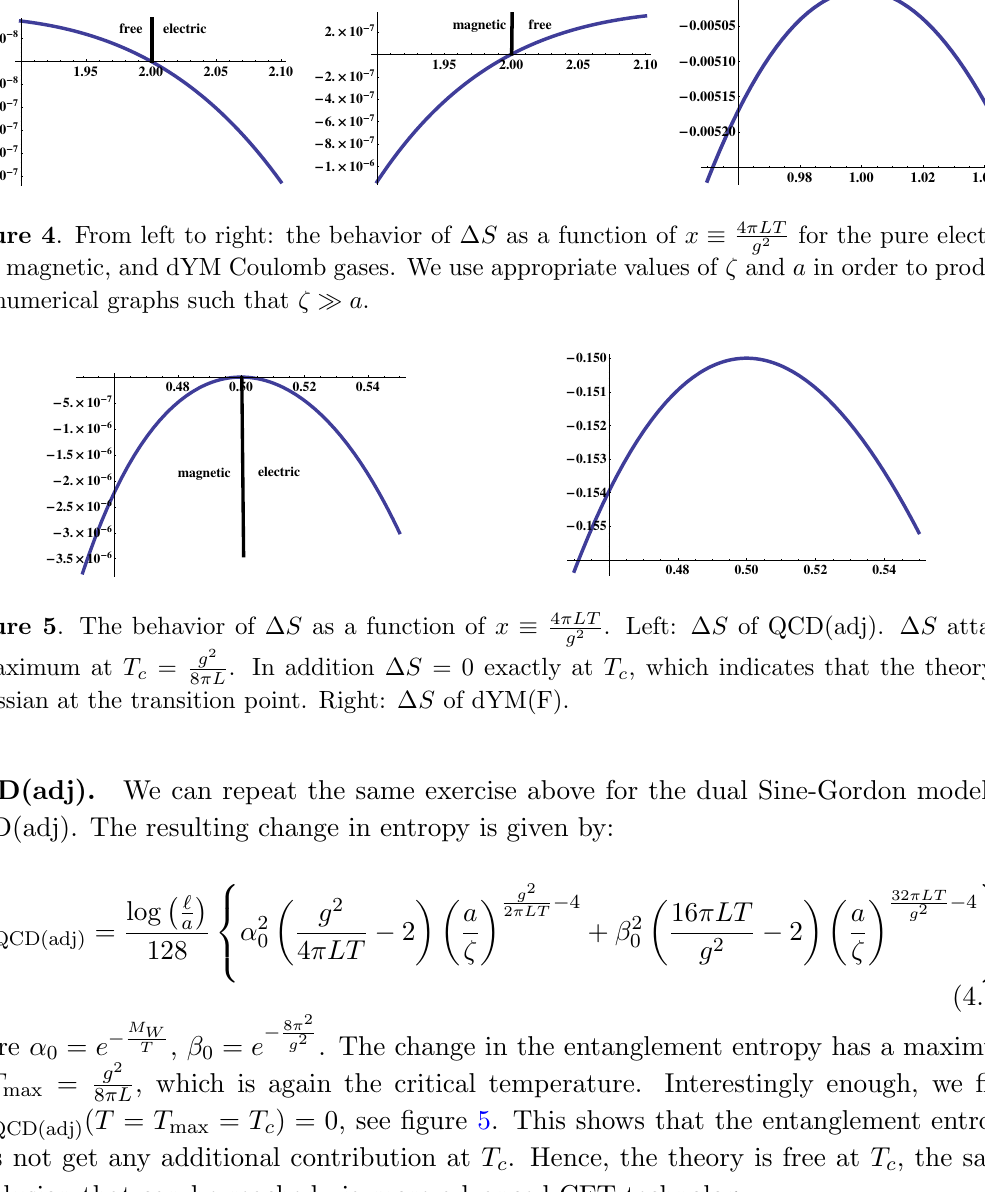
4 (cid:25)LT for the pure electric, g 2 (cid:17)